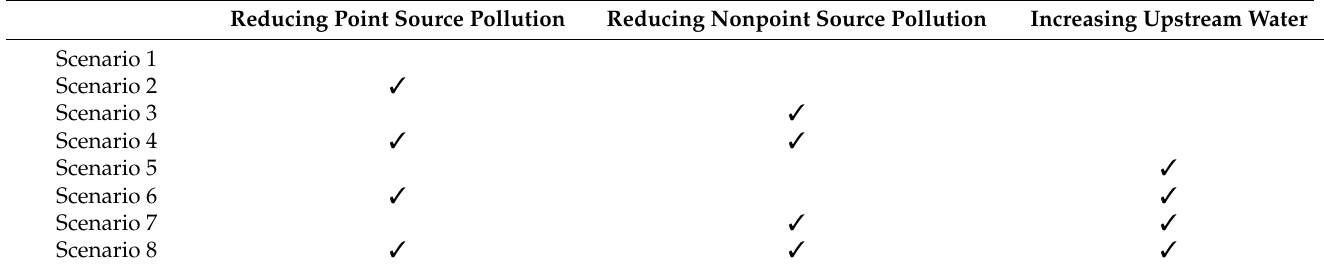
Table 4. Setting of water pollution control scheme.